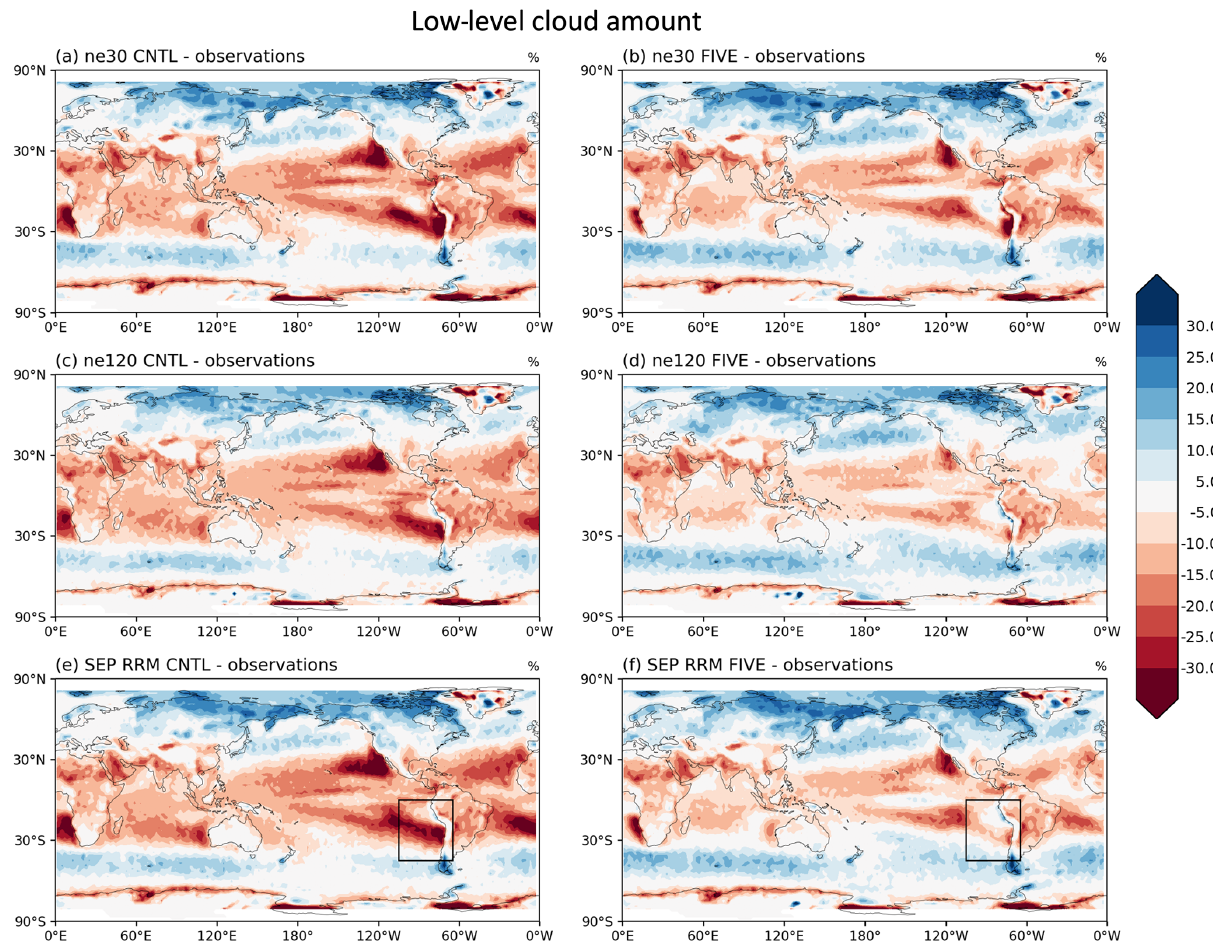
Figure 4. Annual low cloud amount biases computed relative to observations for (a) ne30-CNTL, (b) ne30-FIVE, (c) ne120-CNTL, (d) ne120-FIVE, (e) SEP-RRM-CNTL, and (f) SEP-RRM-FIVE. The box in panels (e) and (f) represents the area of the refined mesh in these